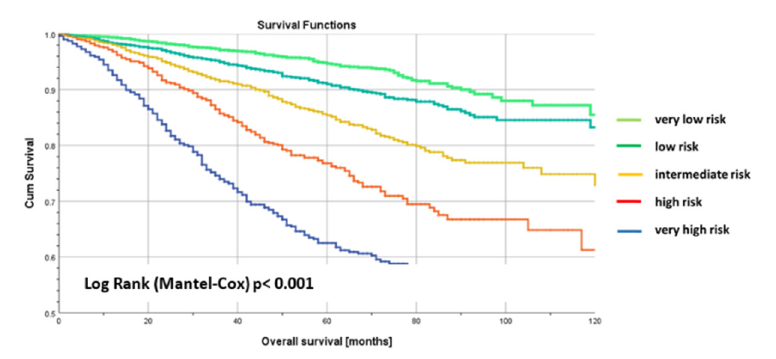
Figure 3. Kaplan-Meier curves of overall survival curves of the deviation set stratified by BRENDA-Score (BRENDA DB) with 10 years follow up. Very low risk = light green, low risk = green, intermediate risk = yellow, high risk = orange, very high risk = blue line.